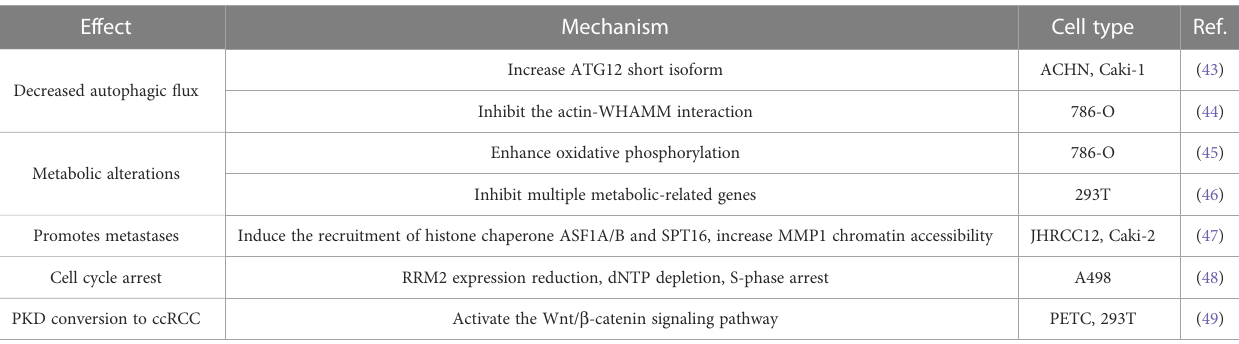
TABLE 2 Effects and mechanisms of SETD2 de fi ciency in